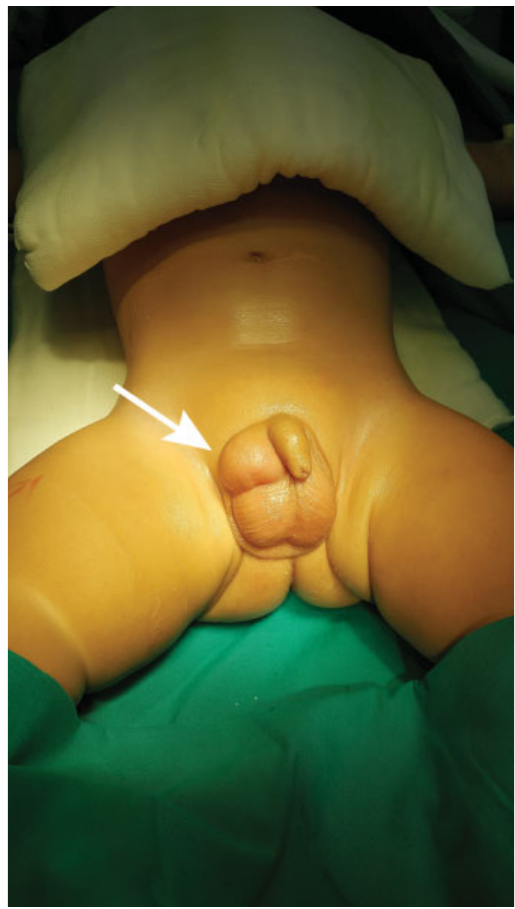
Fig.2 Tumor in the upper half of the right hemiscrotum marked by an arrow.